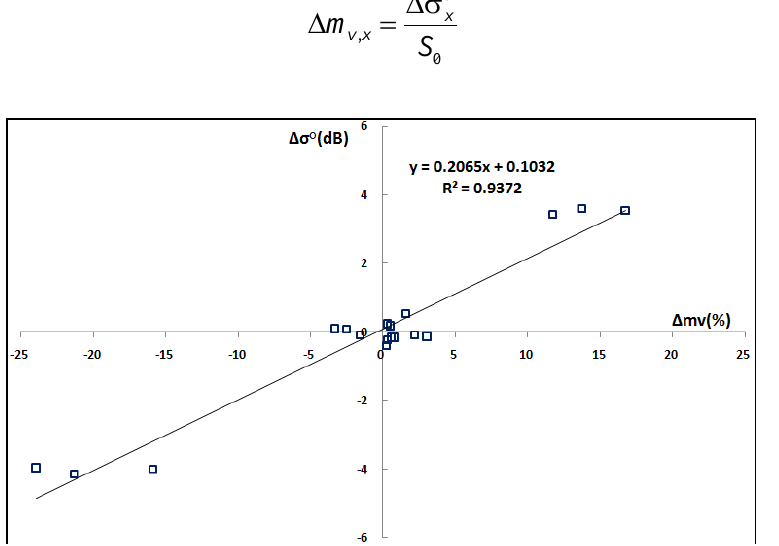
Figure 3. Mean radar signal difference separated into three sub-images, between two successive radar images (over bare soil) Δσ (dB) as a function of moisture variations Δmv(%), applied to 7 successive radar